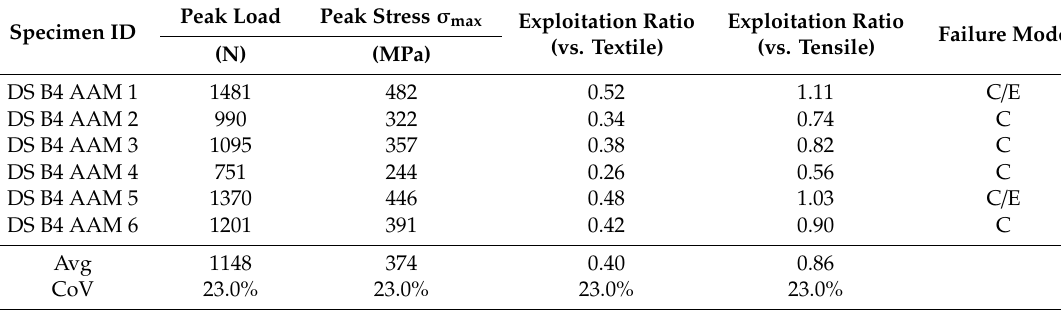
Table 6. Results of direct shear tests.